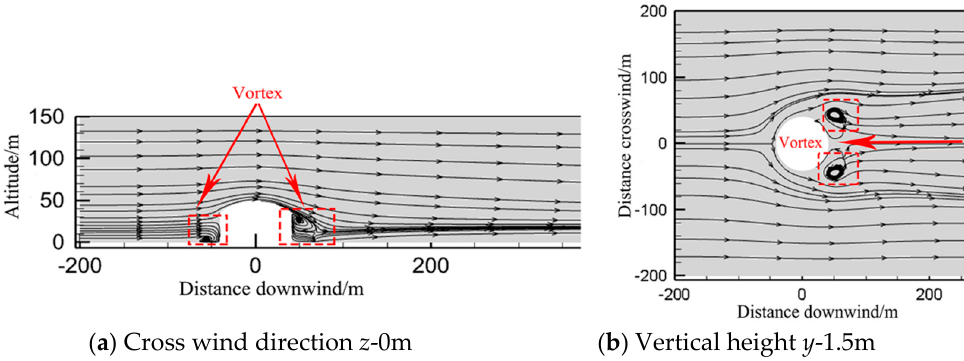
Figure 6. The distribution of wind speed streamlines near the storage tank.